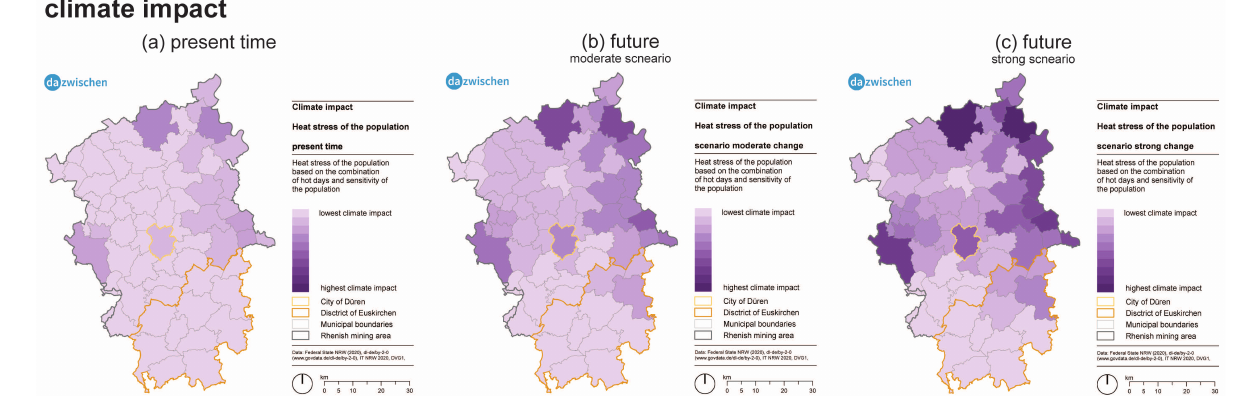
Figure 5. Results for the climate impact of the indicator “Heat stress of population”: ( a ) Indicator expression for the present time ( b ) Indicator expression for the future under a moderate scenario ( c ) Indicator expression for the future under a strong